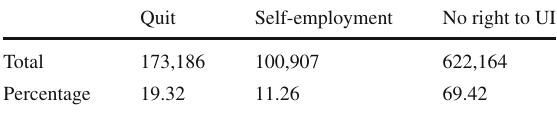
Table 2 STU expansion spells, by type. Source : MCVL